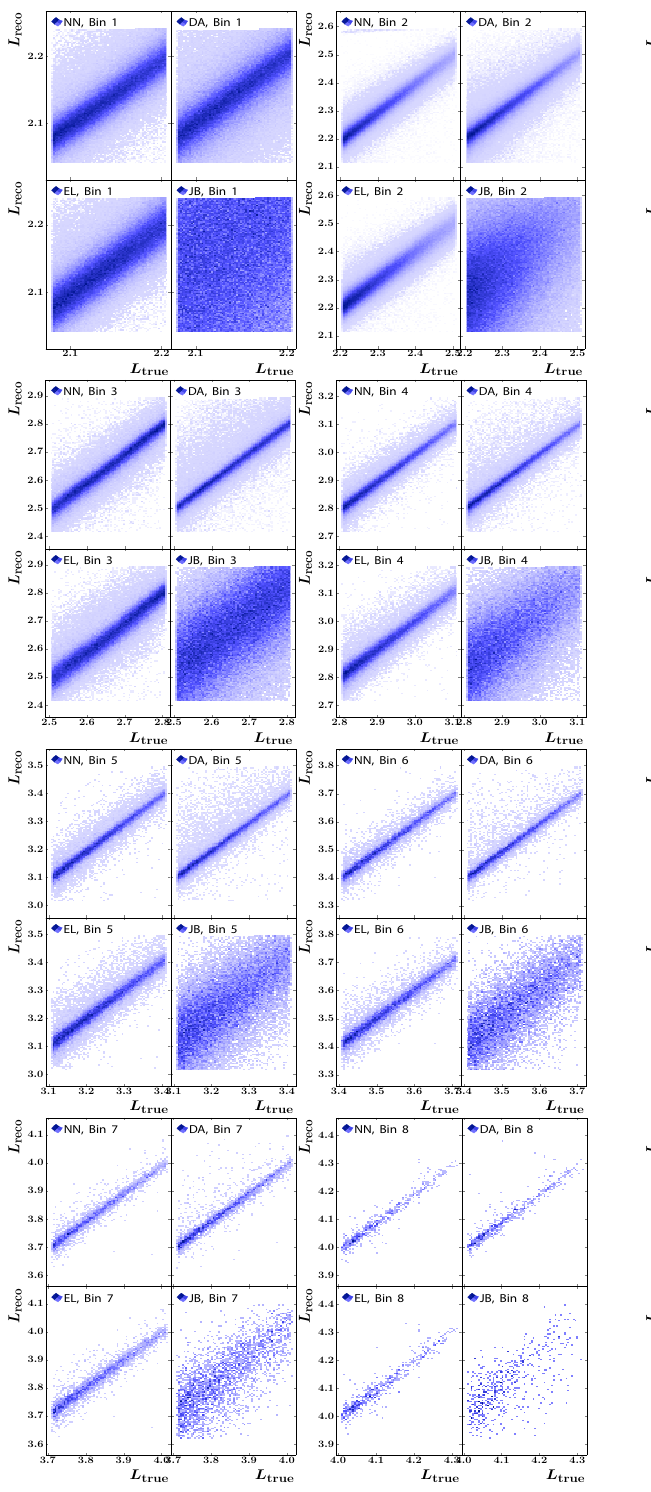
Fig. 7 Distribution of events in L reco = log Q 2 / 1GeV 2 versus / 1GeV 2 plane for various reconstruction methods L true = log Q 2 true in individual analysis bins